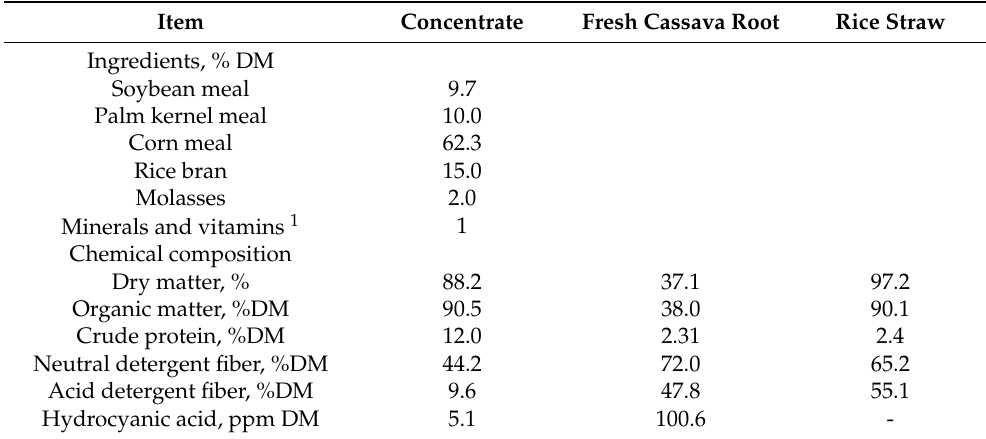
Table 1. Ingredient and chemical composition of concentrate diet, fresh cassava root, and rice straw